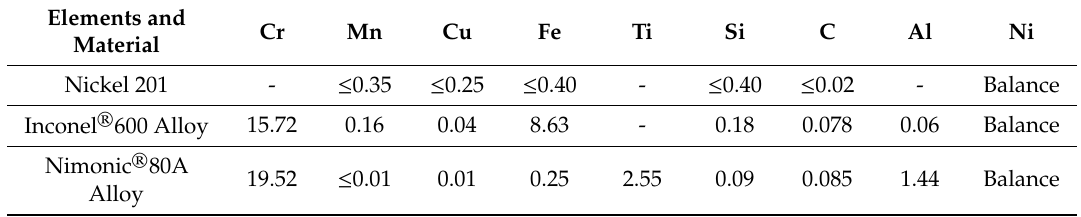
Table 1. Chemical composition of substrate materials